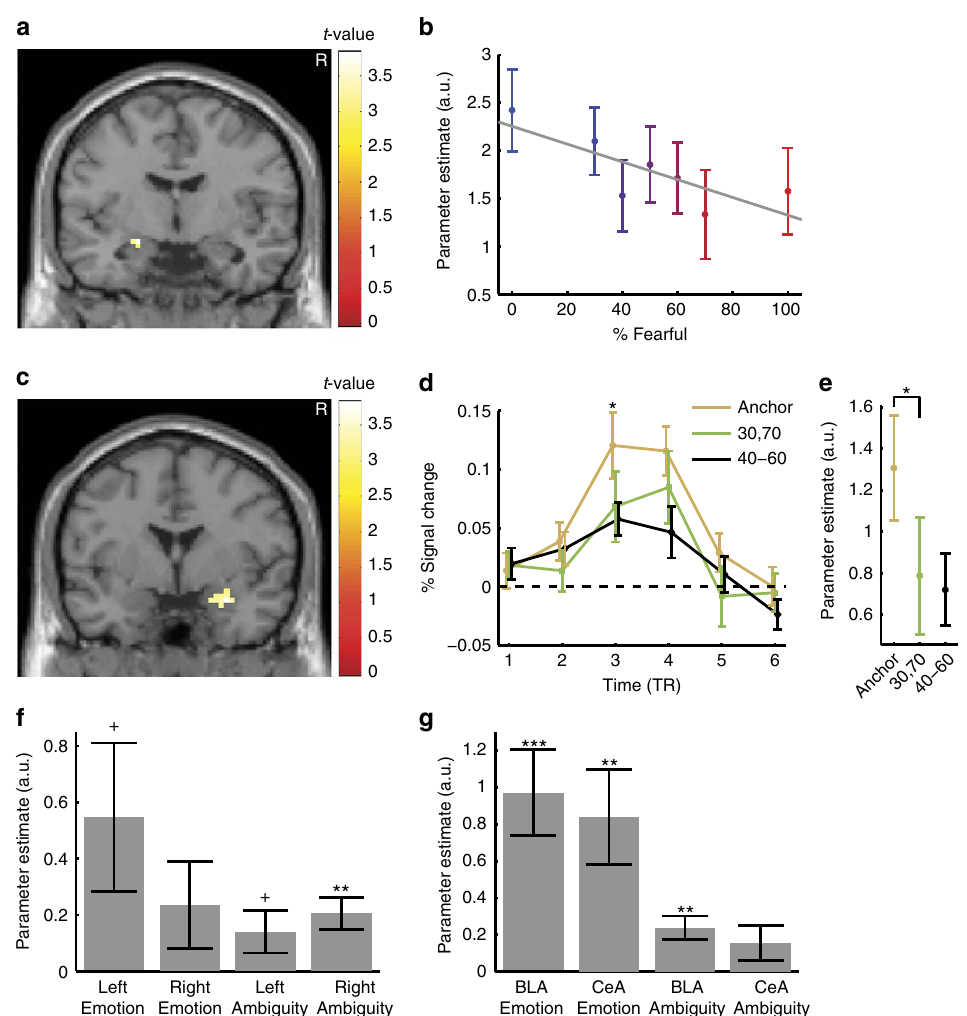
Figure 2 | fMRI results. ( a ) Fear levels were negatively correlated with the BOLD activity in the left amygdala. Here we used a functional amygdala ROI defined by the localizer task (see Methods section). The generated statistical parametric map was superimposed on anatomical sections of the standardized MNI T1-weighted brain template. Images are in neurological format with subject left on image left. R: right. ( b ) Parameter estimate (beta values) of the GLM for each fear level (Pearson correlation: r ¼ (cid:3) 0.79, P ¼ 0.034). The colour scale denotes increasing degree of fear (cf. Fig. 1b). Error bars denote one s.e.m. across 19 subjects. ( c ) Ambiguity levels were correlated with the BOLD activity in the right amygdala (functional ROI defined by localizer task). ( d ) Time course of the BOLD response in the right amygdala (averaged across all voxels in the cluster) in units of TR (TR ¼ 2s) relative to face onset. Error bars denote one s.e.m. across subjects. One-way repeated ANOVA at each TR: * P o 0.05. ( e ) Parameter estimate of the GLM for each ambiguity level (one-way repeated-measure ANOVA, P ¼ 0.0025). Error bars denote one s.e.m. across subjects. Asterisks indicate significant difference between conditions using paired two-tailed t -test. * P o 0.05. ( f ) Mean GLM parameter estimate of all voxels within the functional ROI for each side of the amygdala and for each aspect of the emotion coding. Error bars denote one s.e.m. across subjects. T -test against 0: ** P o 0.01, and þ : P o 0.1. ( g ) Peak voxel activity within the basolateral nuclei (BLA) and central nuclei (CeA) for each aspect of the emotion